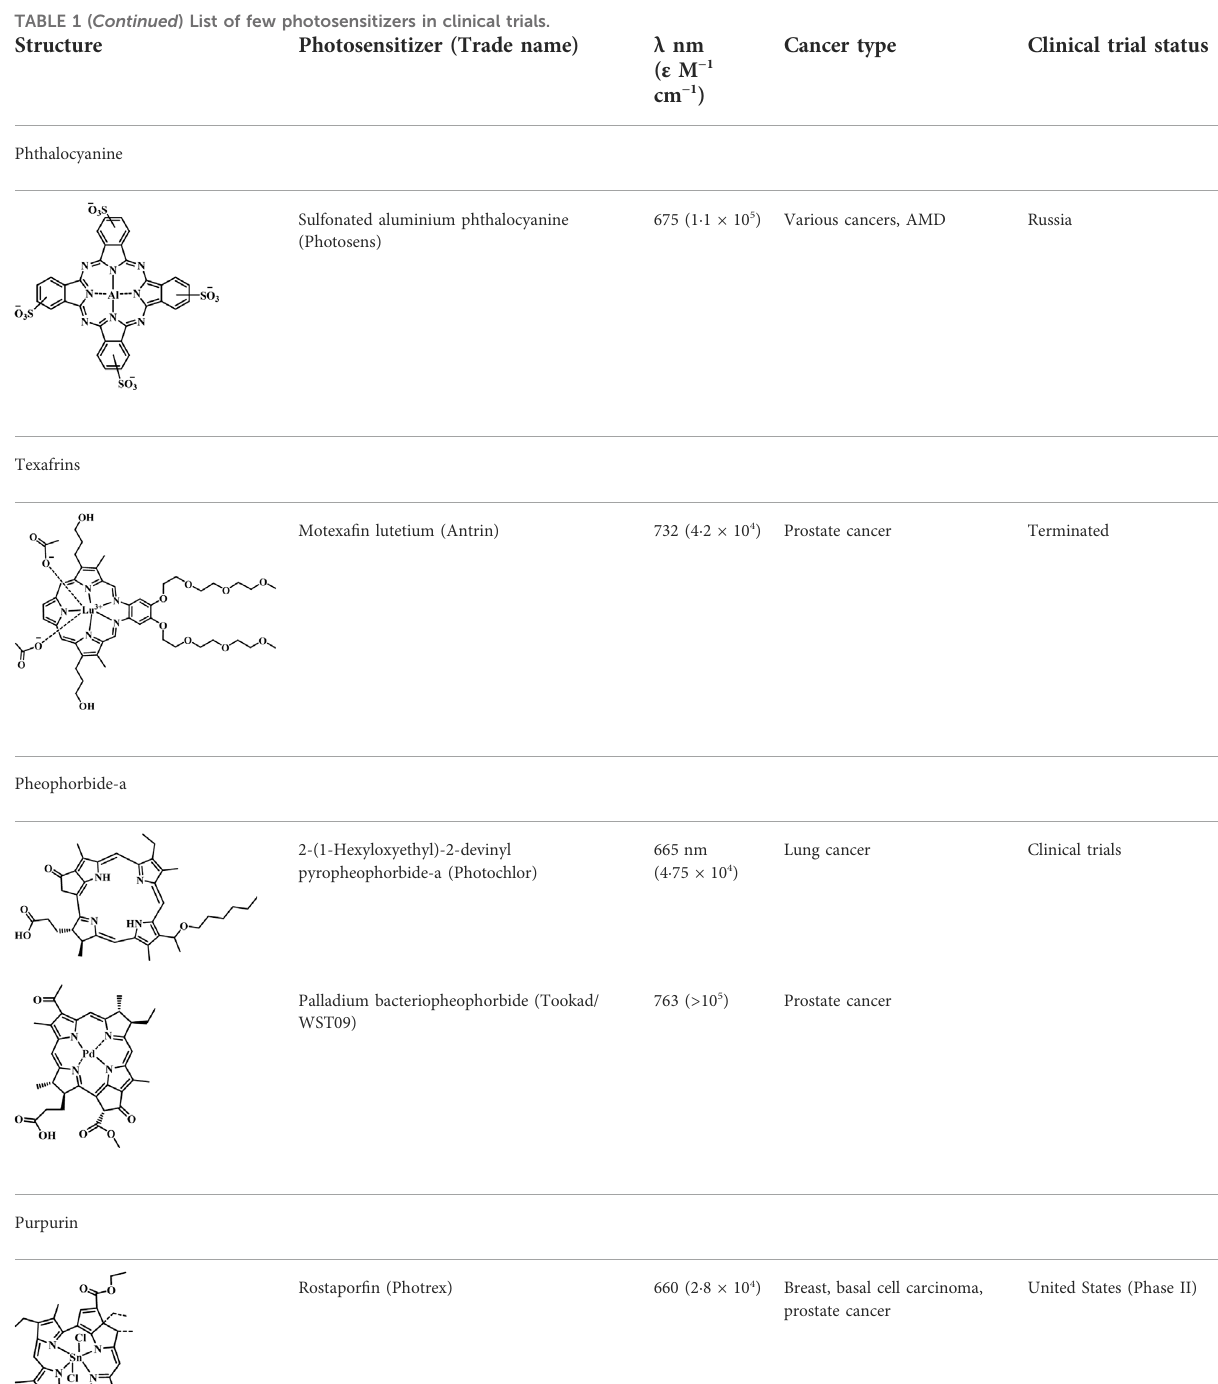
TABLE 1 ( Continued ) List of few photosensitizers in clinical trials.